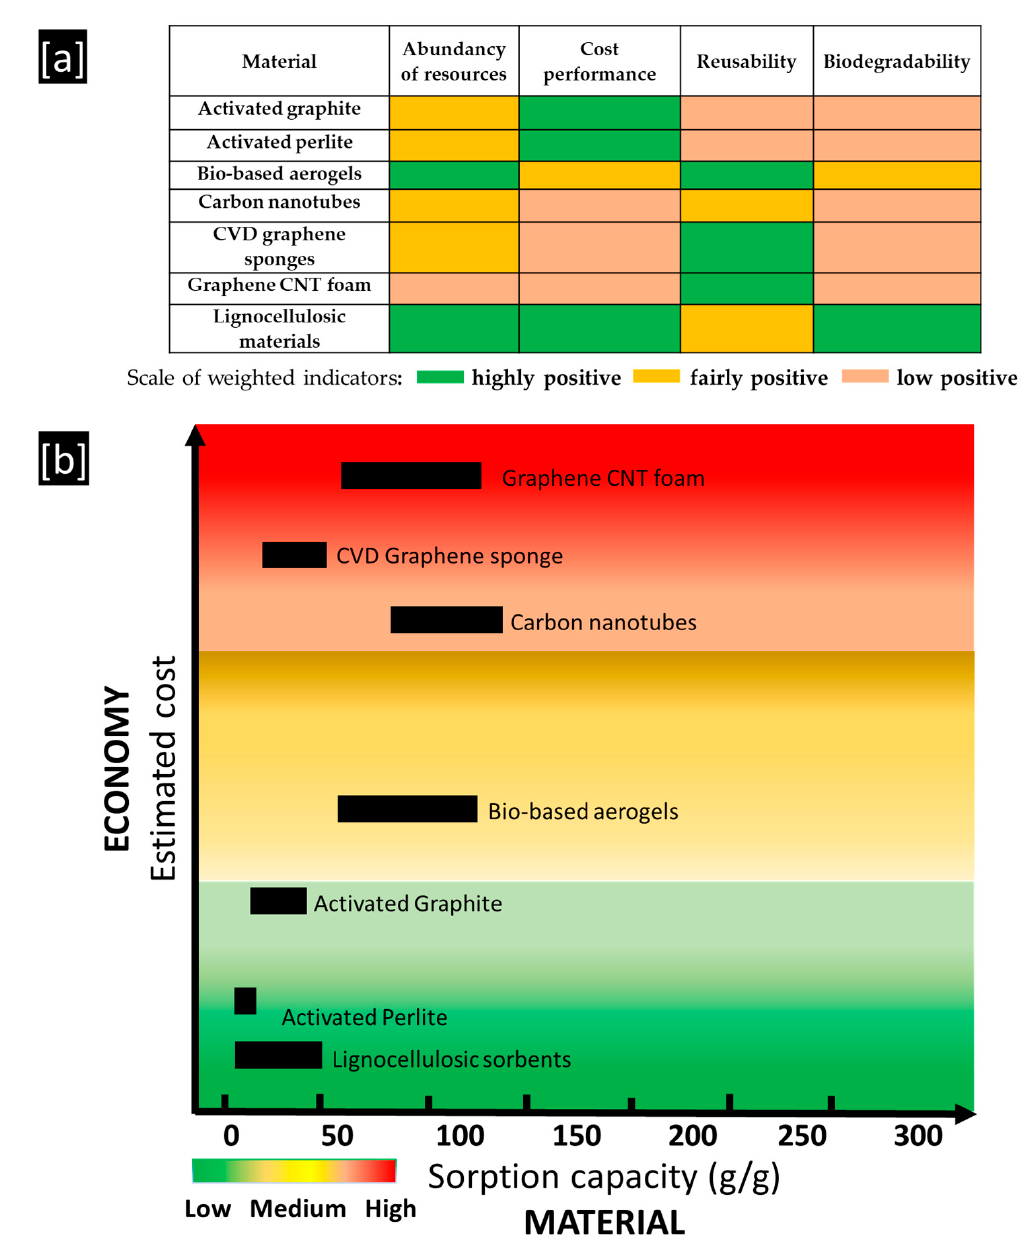
Figure 11. ( a , b ) Evaluation of materials as a process of an integrated approach based on the terms of material–environment–economy (authors’ own study, data from [99–106]).